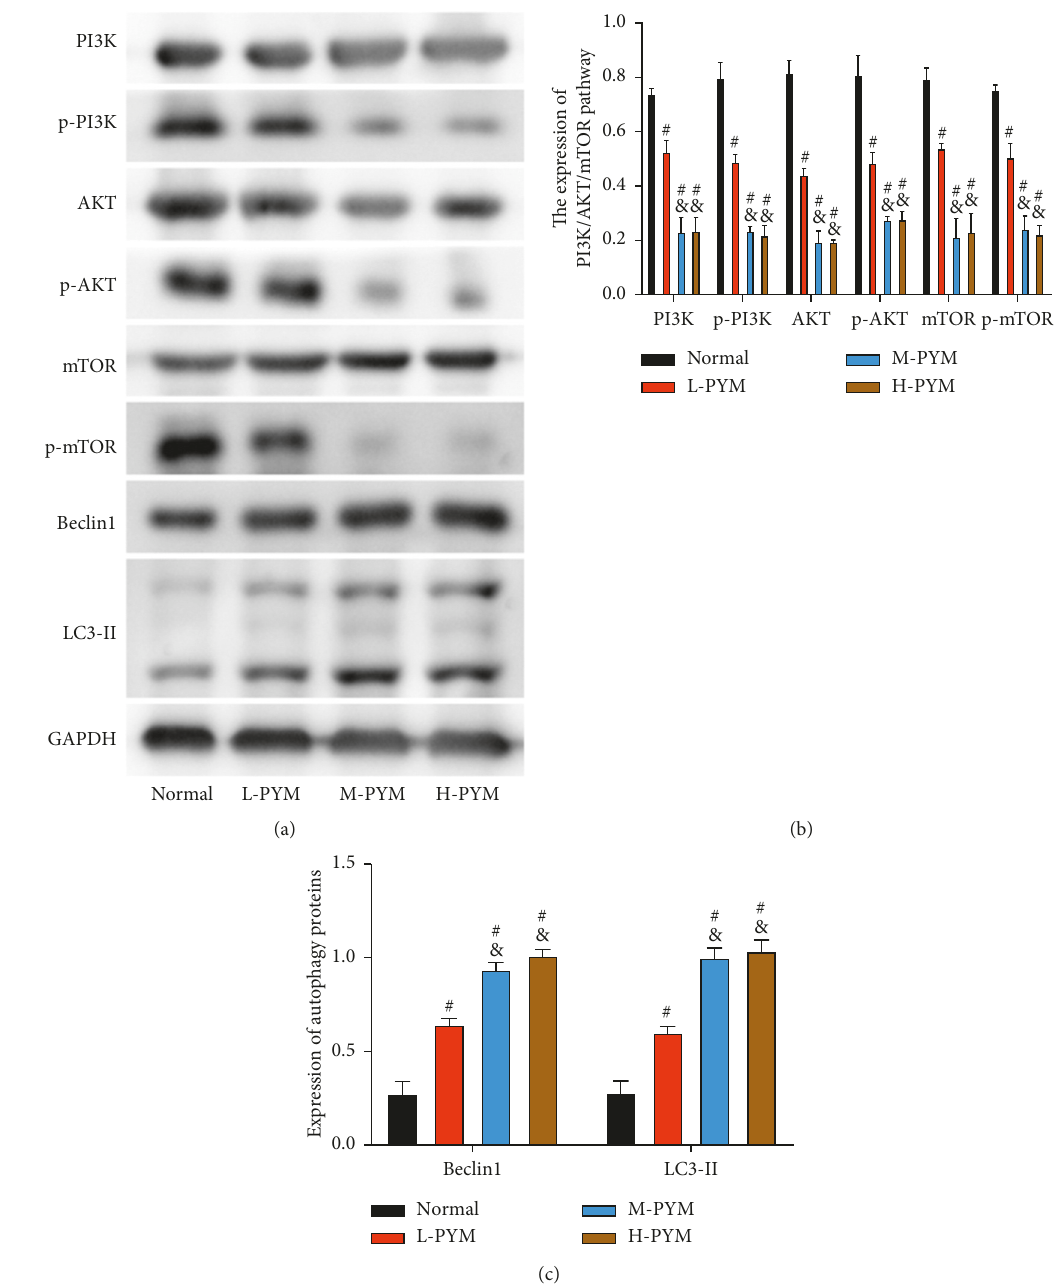
Figure 1: Impacts of PYM on protein expression of OC cells. (a) WB map. (b) PI3K/AKT/mTOR pathway protein expression. (c) Autophagy protein expression. Compared with the normal group, # P